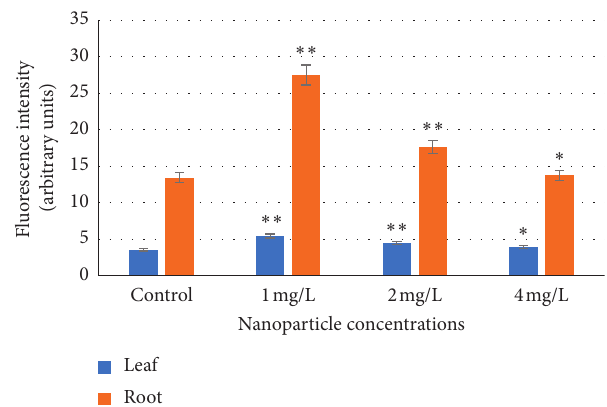
Figure 4: The effect of ZnO NPs on ROS generation in H. vulgare L. seedlings was studied using the fluorescent dye DCFDA. Values are the mean of three replicates with SD. ∗ Significant difference from control ( p < 0 . 01); ∗∗ significant difference from control ( p < 0 . 01).